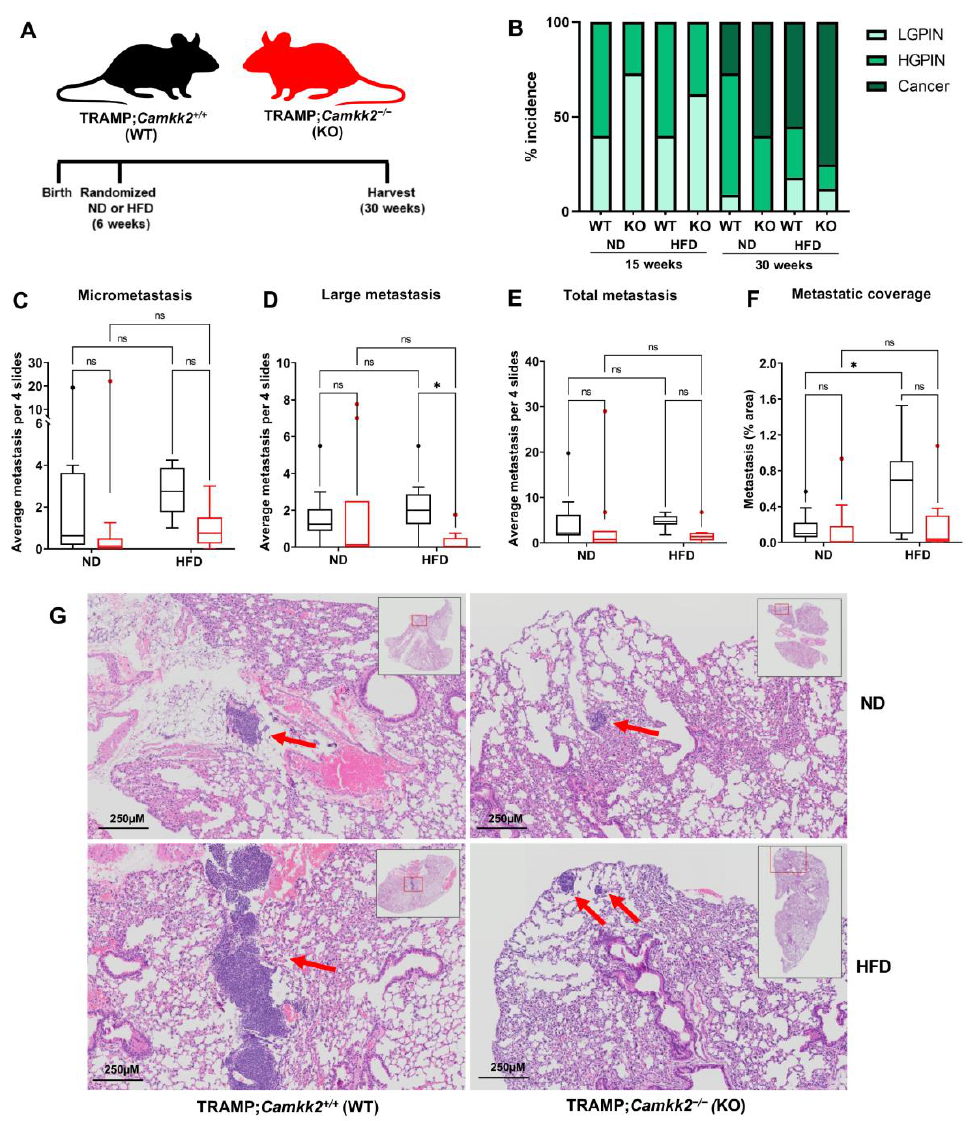
Figure 4. Camkk2 knockout decreases high-fat diet-induced metastatic colonization of NEPC in TRAMP mice. ( A ) Schema for mouse experiment in which C57BL/6 TRAMP; Camkk2 +/+ and TRAMP; Camkk2 − / − mice were fed either a high-fat diet (HFD) or normal diet (ND) (HFD WT n = 8; HFD KO n = 8; ND WT n = 9; ND KO n = 10). ( B ) % low-grade PIN (LGPIN), high-grade PIN (HGPIN), and cancer incidence among cohorts. Lung metastasis was quantified by counting incidents of ( C ) micrometastases (area of metastasis is <10.000 µ m 2 ), ( D ) large metastases (area of metastasis is > 10.000 µ m 2 ), or ( E ) any metastatic lesions. In addition, ( F ) image analysis was per- formed on lung H&E slides to quantify the % metastatic area relative to total lung (total lung = 100%). ( G ) Representative H&E stains of lung metastases (red arrows) were found. For full data set and analyses, see Supplementary File S3. * p < 0.05; Two-way